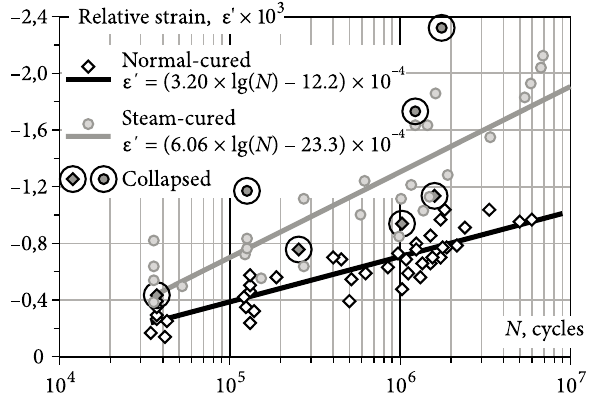
Fig. 6. Compressive strains induced by the cyclic creep